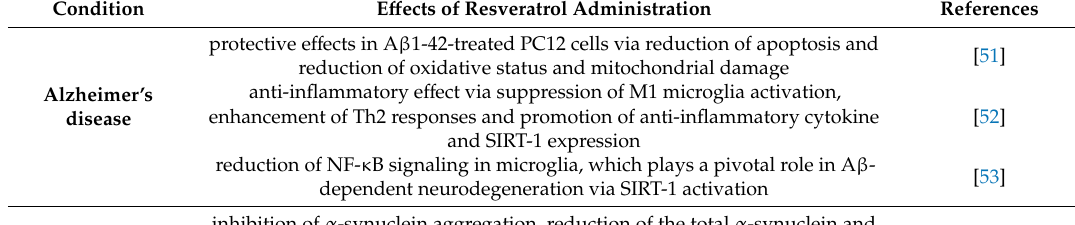
Table 1. The activities of resveratrol in selected